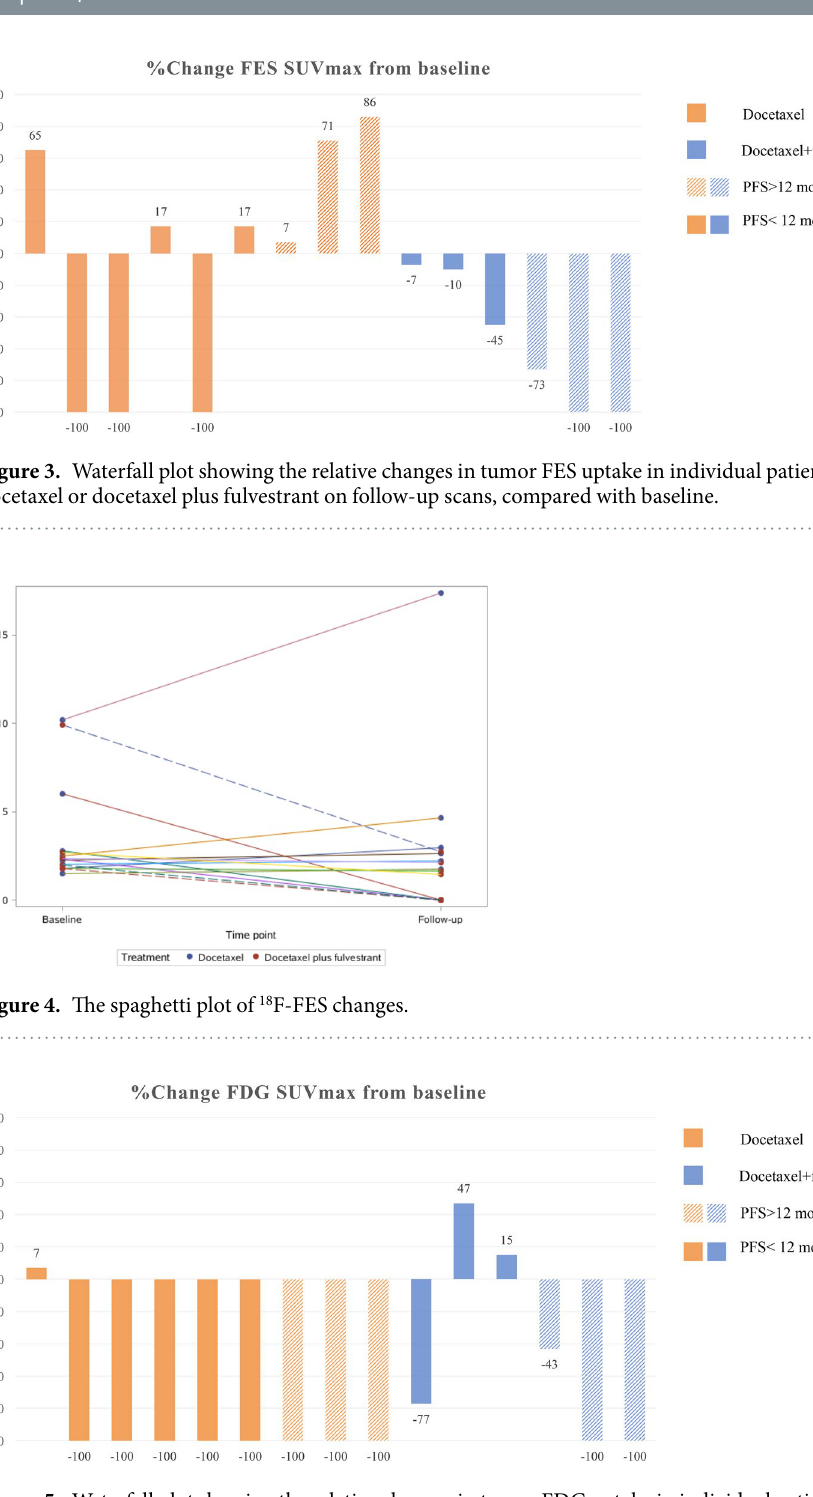
Figure 5. Waterfall plot showing the relative changes in tumor FDG uptake in individual patients treated with docetaxel or docetaxel plus fulvestrant on follow-up scans, compared with